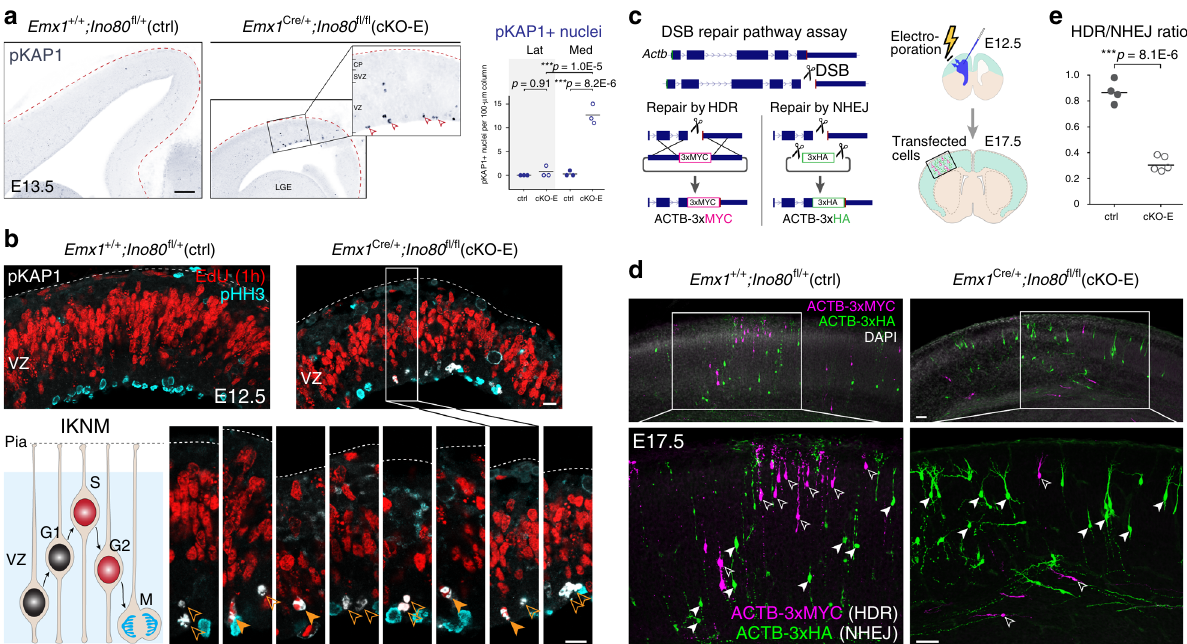
Fig. 4 Impaired HR DNA repair and unrepaired DSBs following Ino80 deletion. a Immunostaining for DSB marker pKAP1 (blue) revealed a signi fi cant increase in unrepaired DSBs in medial, but not lateral, E13.5 cKO-E neocortex (data are mean, one-way ANOVA with Tukey ’ s post hoc test, n = 3 animals). A majority of pKAP1 + nuclei in cKO-E were positioned near the ventricular surface (open arrowheads). CP cortical plate. b Analysis of S-phase NPCs by 1- h pulse of thymidine analog EdU (red), M-phase NPCs by phospho-H3 (pHH3) immunostaining (cyan), and DSBs by pKAP1 immunostaining (white) in E12.5 cortex. NPCs undergo interkinetic nuclear migration (IKNM) and their nuclear position in distinct phases of the cell cycle is depicted in the schematic. pKAP1 staining revealed unrepaired DSBs in 1-h EdU-positive (solid arrowheads, S-phase) and EdU-negative (open arrowheads, post-S-phase) cells near the ventricular surface. Ventricular pKAP1 staining did not colocalize with pHH3, suggesting that NPCs with unrepaired DSBs did not progress successfully into mitosis. c Schematic illustration of in vivo DSB repair assay. A genomic DSB is induced by CRISPR – Cas9 within the coding region of Actb near the C terminus. Two reporter repair templates were designed such that repair of the DSB by HDR would lead to in-frame expression of ACTB-3xMYC, whereas repair by NHEJ would lead to expression of ACTB-3xHA. CRISPR – Cas9 and reporter repair constructs were co-transfected into cortical NPCs at E12.5 by